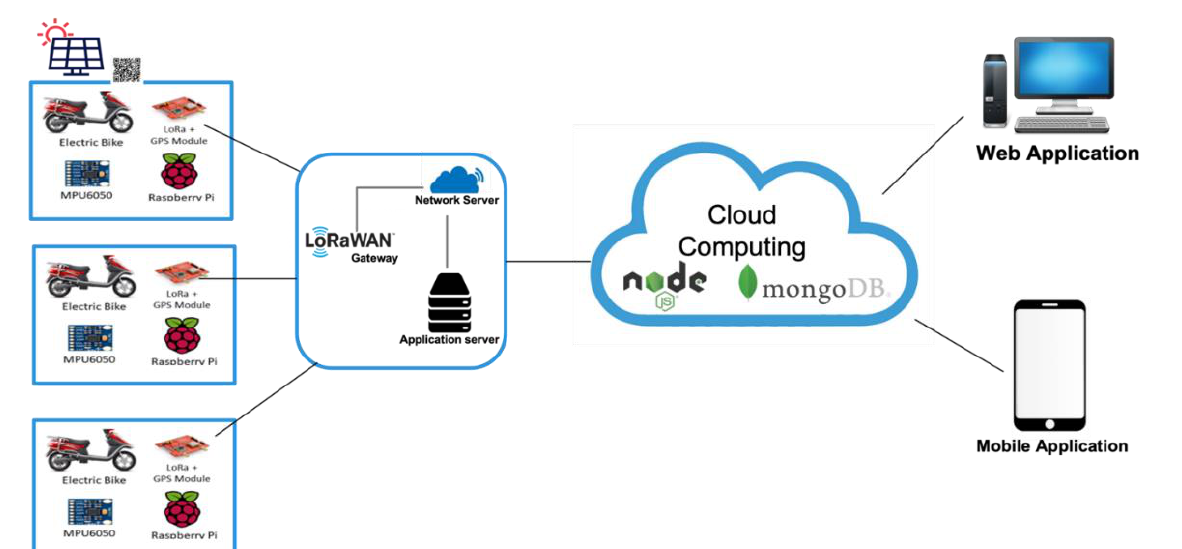
Figure 5. Prototype Implementation of the Proposed System.